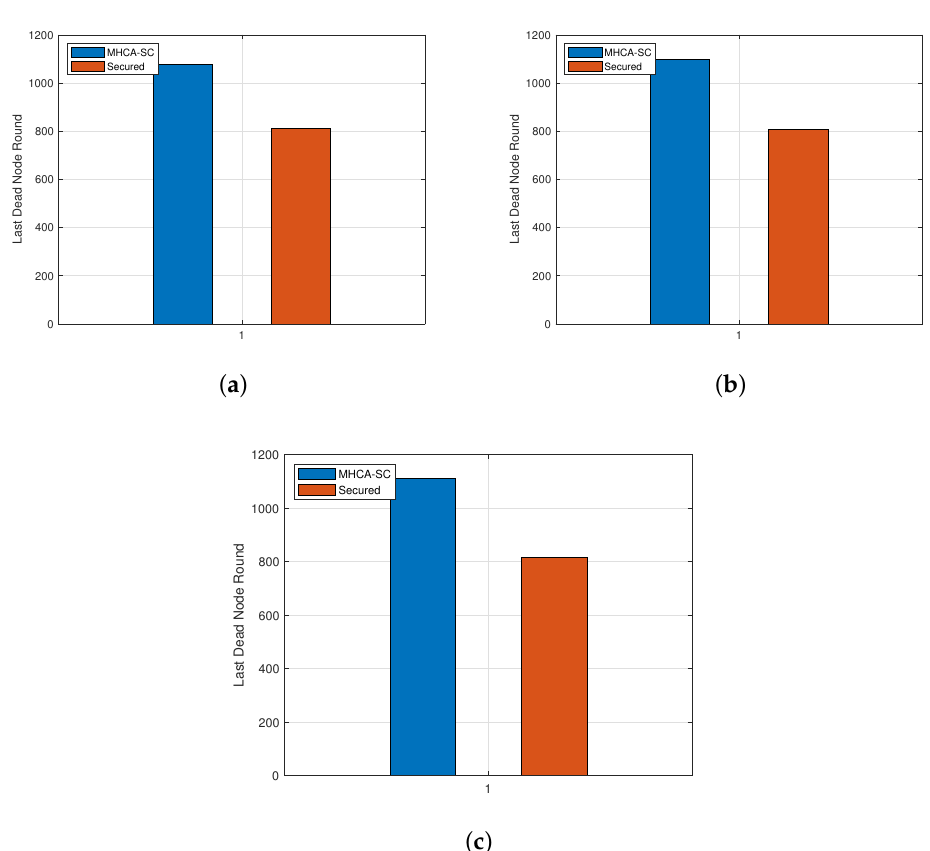
Figure 10. Last dead node. ( a ) 300-node model. ( b ) 400-node model. ( c ) 500-node model.